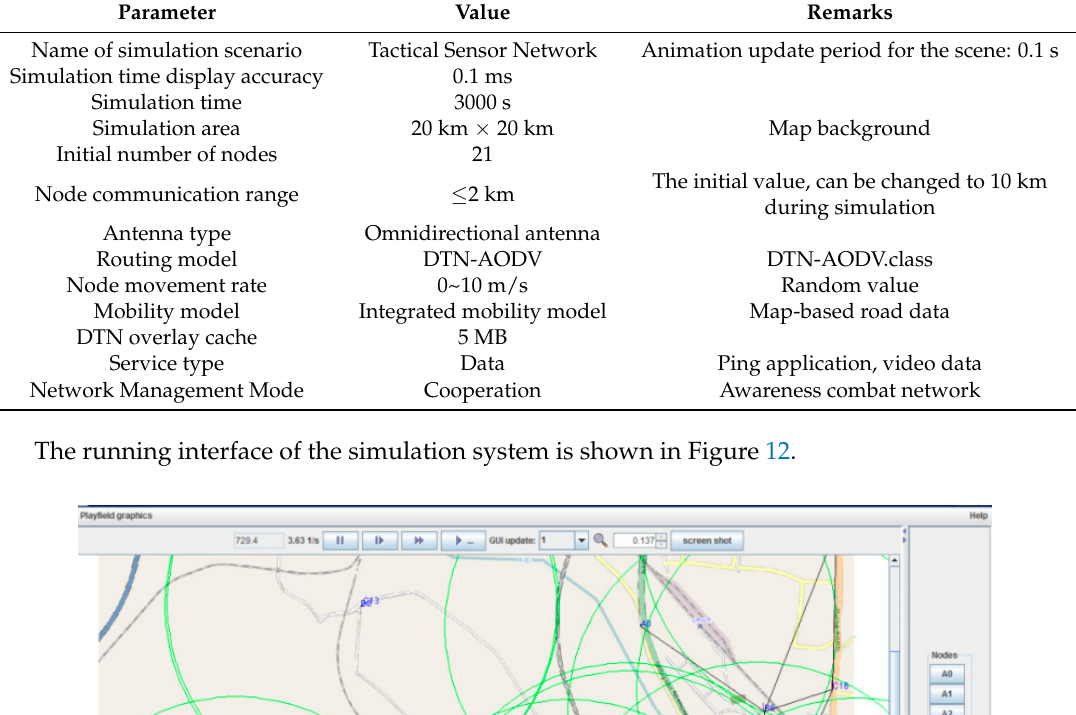
Table 1. Basic parameter settings for simulation.